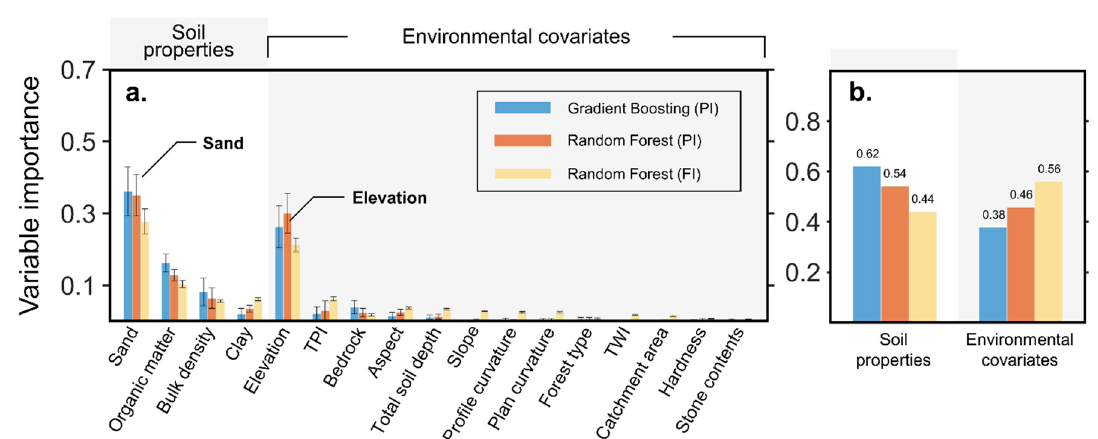
Figure 4. ( a ) The variable importance of each predictor, and ( b ) the summation variable importance of soil properties and environmental covariates for predicting FC. Variable importance was suggested using the permutation importance of GB and RF models, and feature importance was suggested for RF.